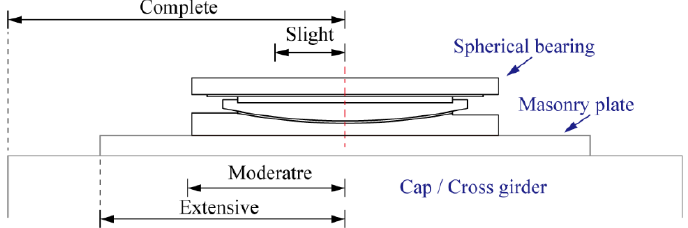
Figure 11. Definition of the damage states for bearings.